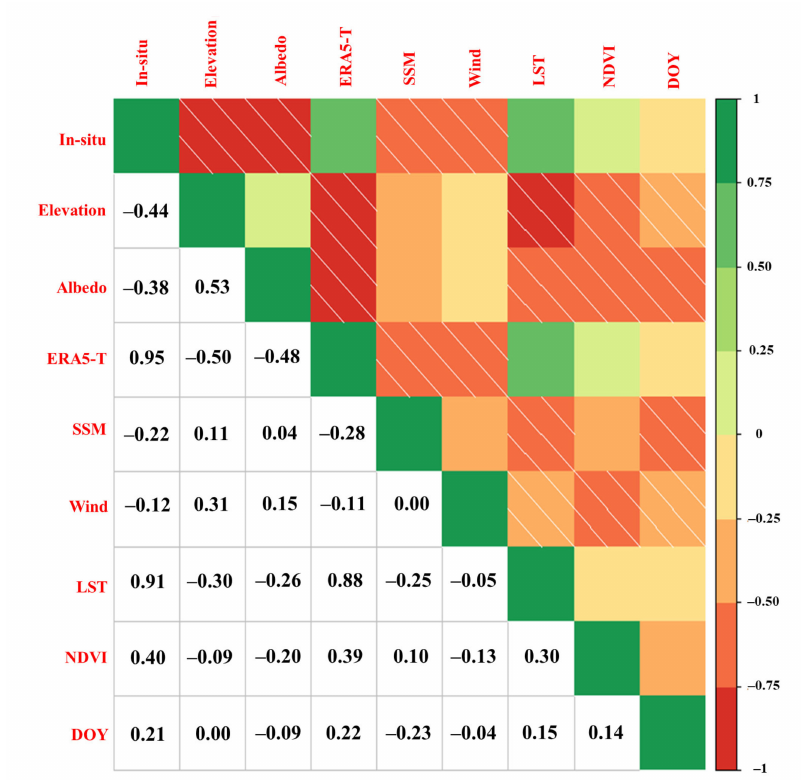
Figure 4. The correlation coefficient between air temperature and each predictor variables. The blue color represents positive relationship while the red color means negative relationship. The lower triangle of the figure represents the specific PCC values between two variables while the upper triangle uses colors and oblique lines to represent the positive or negative